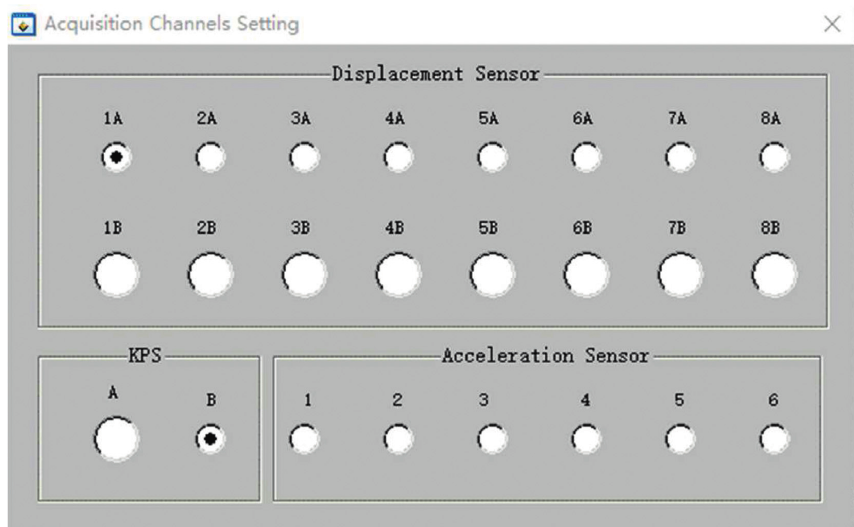
Figure 7: The acquisition channel setting